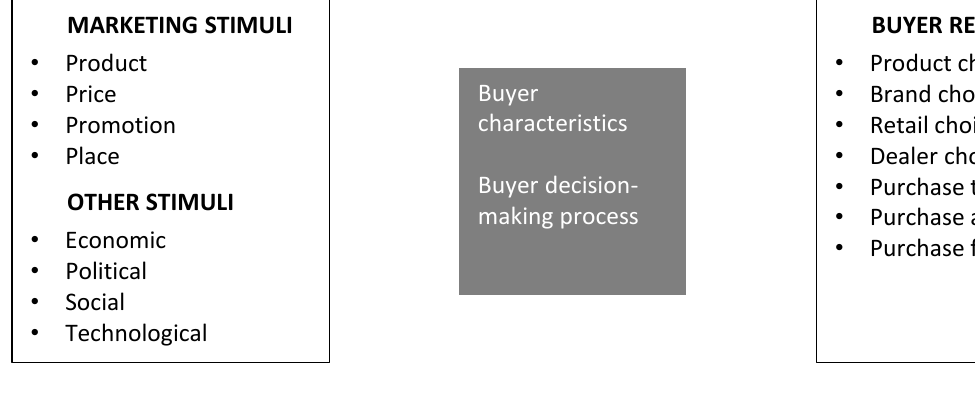
Figure 1. The “Black Box” model of consumer